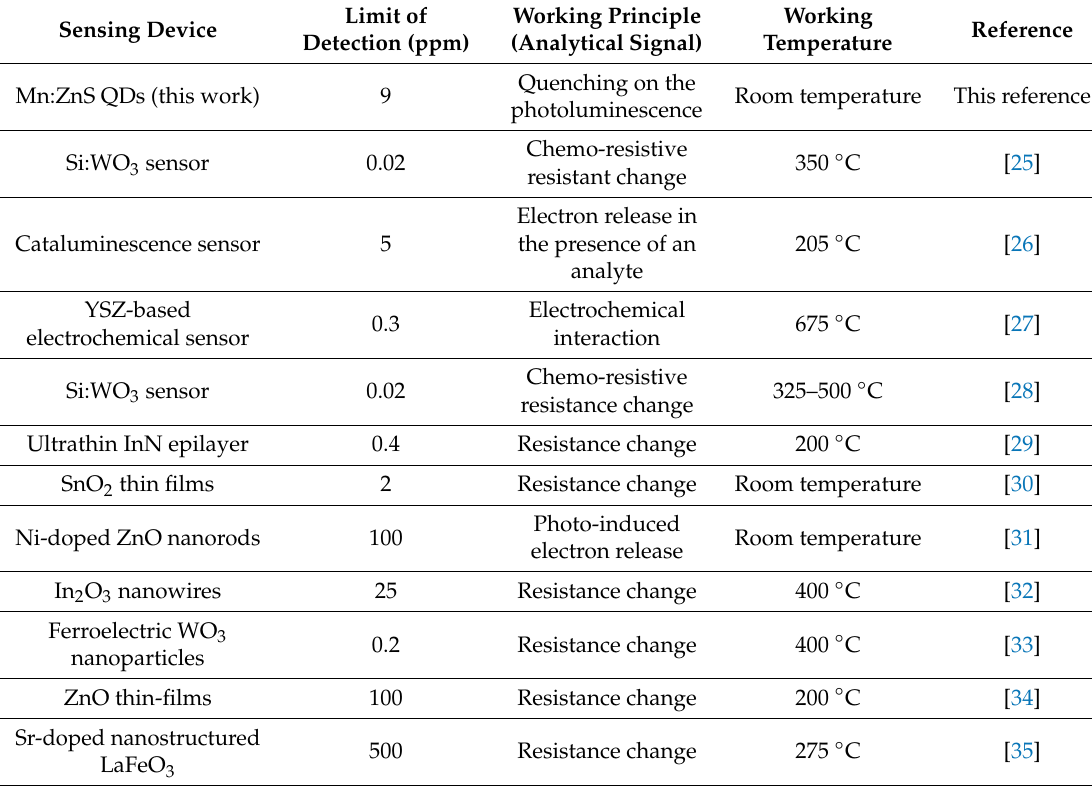
Table 1. Comparison of the detection limits for acetone quantification obtained using the developed sensor with other reported portable acetone sensing